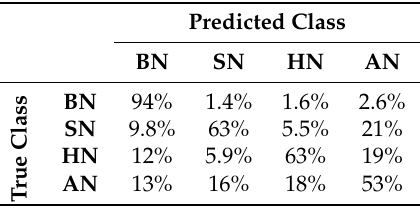
Table 5. Results achieved 1D CNN.